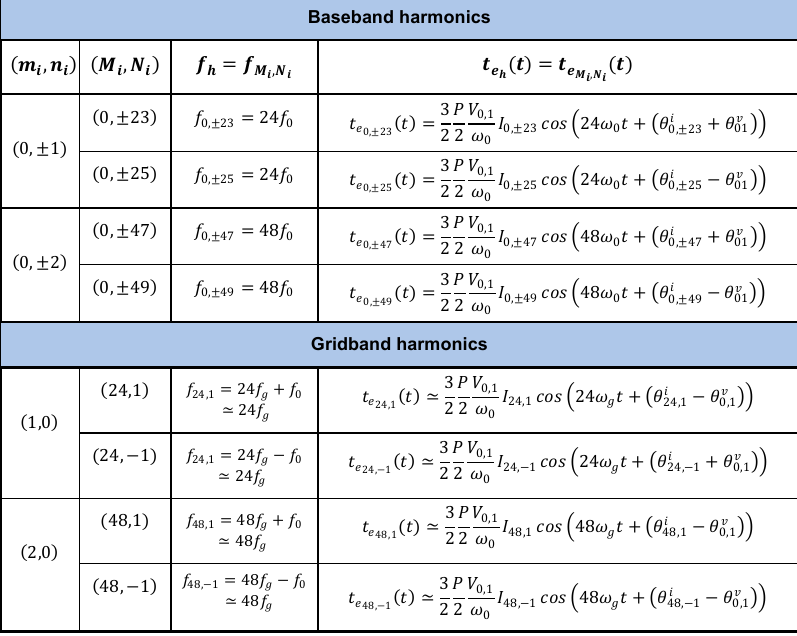
Figure 9. Harmonic families in a 24/24-pulse LCI system: baseband and gridband families.